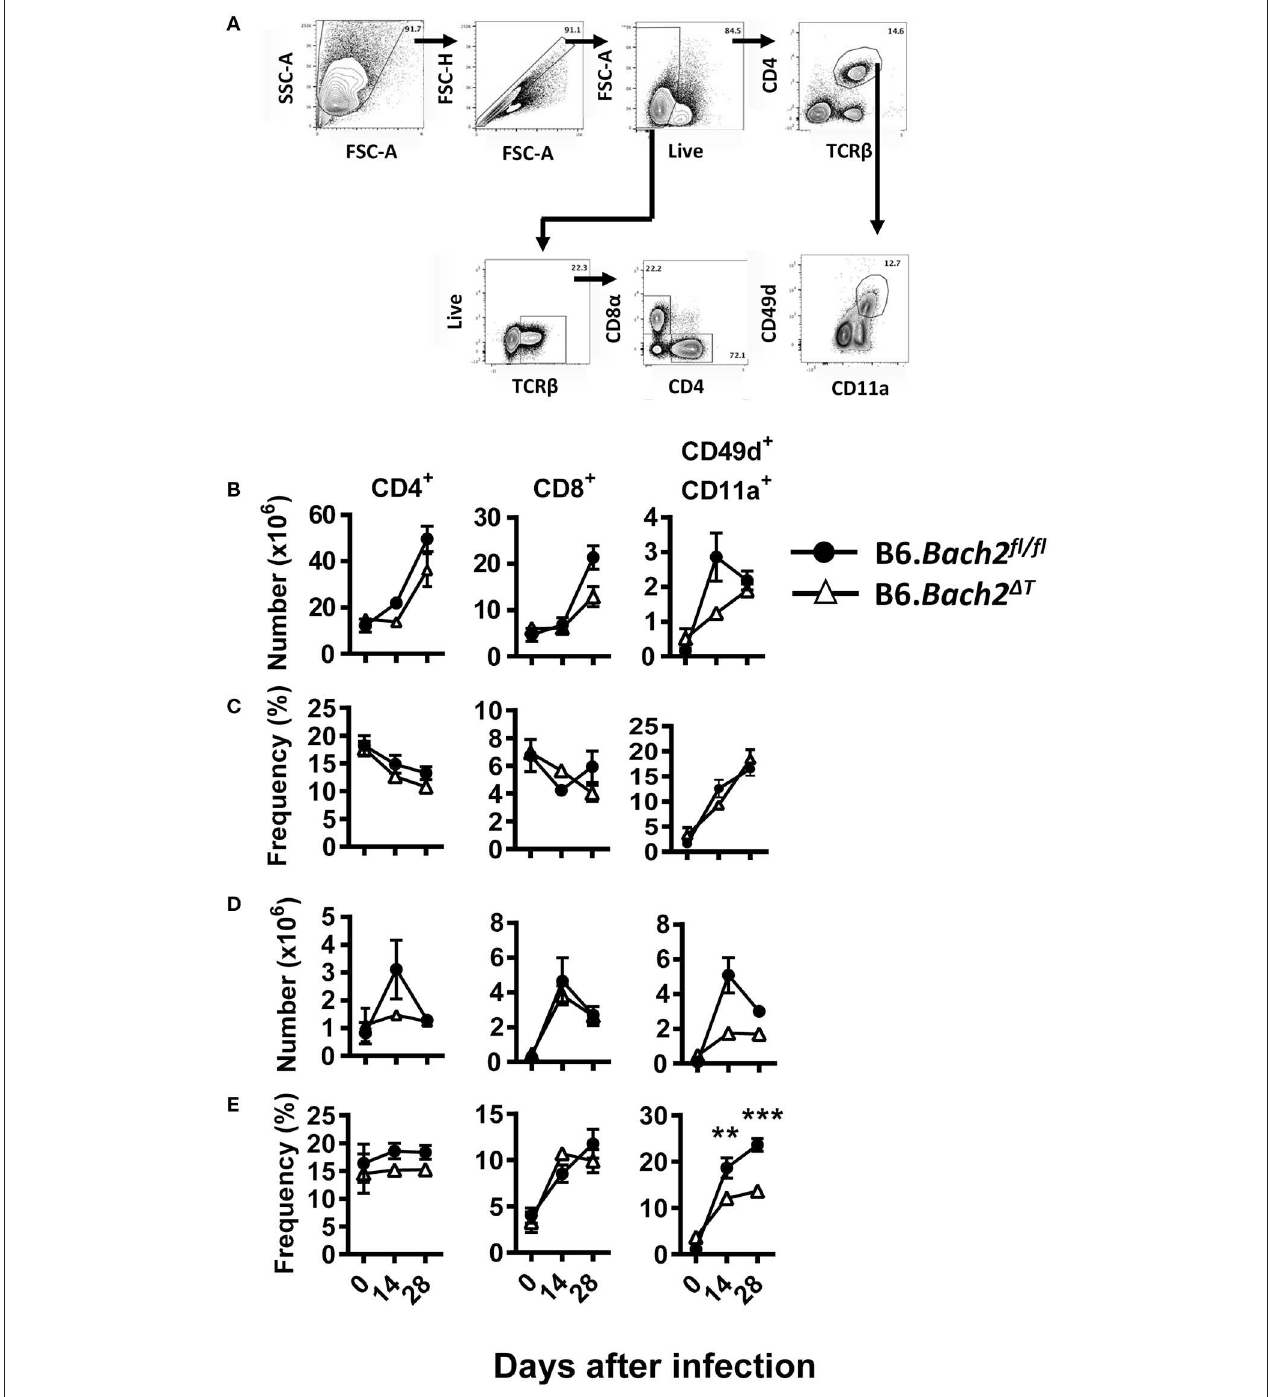
FIGURE 6 | T cell-specific BACH2 influences tissue-specific expansion of antigen experienced CD4 + T cells following L. donovani infection. (A) Gating strategy for CD4 + T, CD8 + T, and antigen-experienced (CD49d + CD11a + ) CD4 + T cells in the spleen (B,C) and liver (D,E) of B6. Bach2 ∆ T (open triangles) and B6. Bach2 fl / fl (closed circles) mice infected with L. donovan at 0, 14, and 28 days p.i., The numbers (B,D) and frequencies (C,E) of CD4 + T, CD8 + T, and antigen-experienced CD4 + T cells, as indicated, were measured by flow cytometry. n = 4–7 mice per time point, mean ± SEM, ** P < 0.01, *** P < 0.001 significance assessed by Mann-Whitney